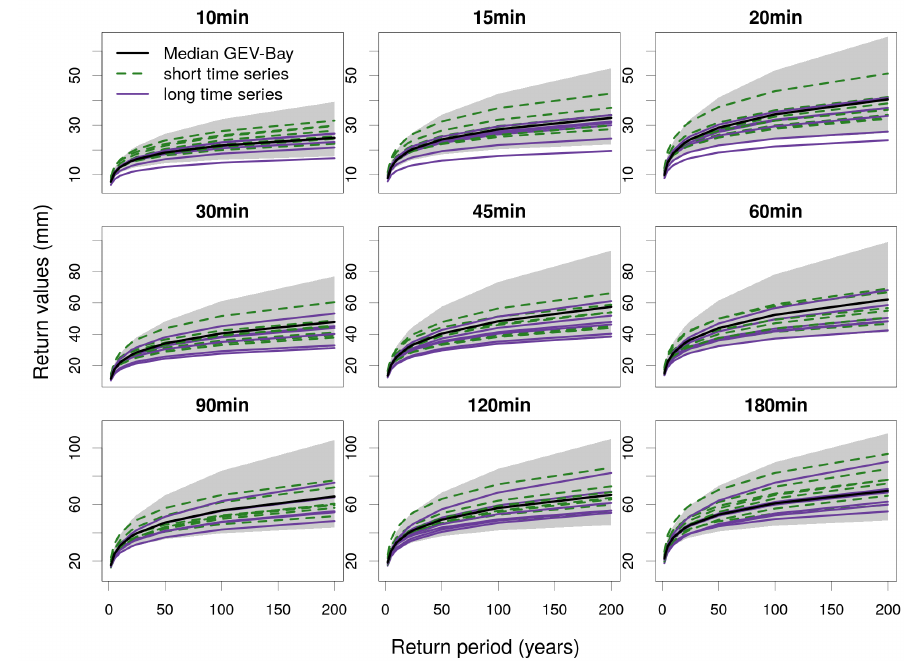
Figure 8. As in Figure 7, but for